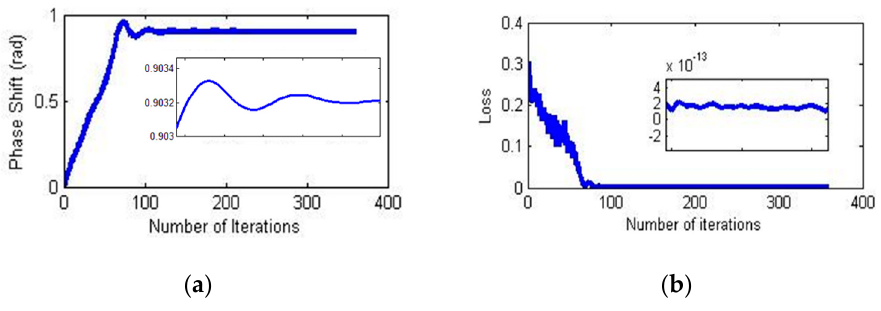
Figure 10. Estimation process. ( a ) Phase shift between two signals; ( b ) loss value during training.